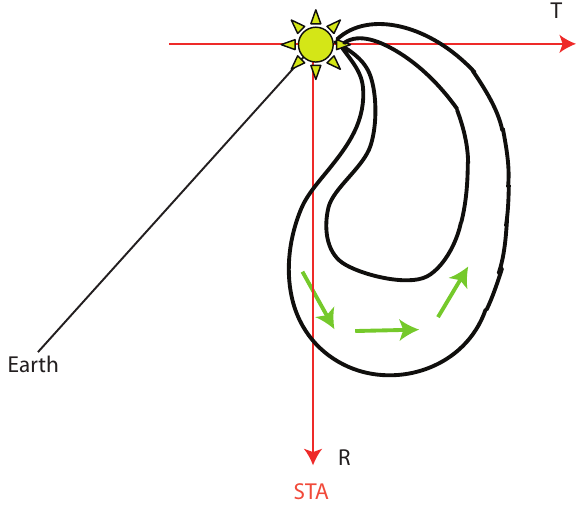
Fig. 9. A possible configuration of the flux rope ICME encountered by STA on 7–8 November 2008. Green arrows show the direction of the axial magnetic